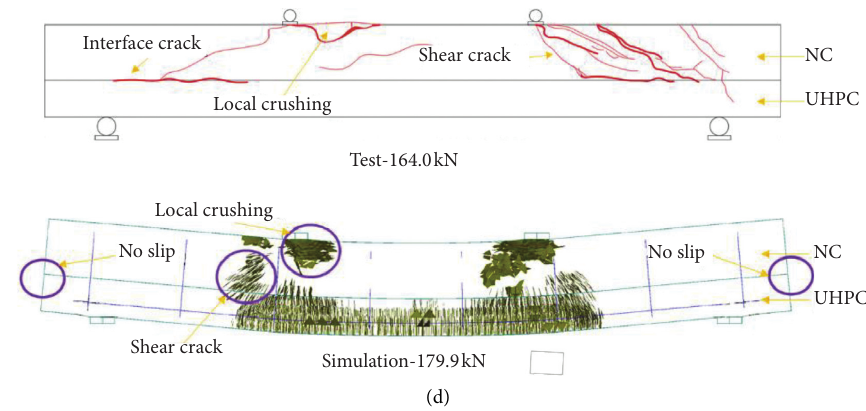
Figure 24: Experimental and numerical comparisons of failure modes. (a) Specimen U50. (b) Specimen U60. (c) Specimen U70. (d) Specimen U60-LS.